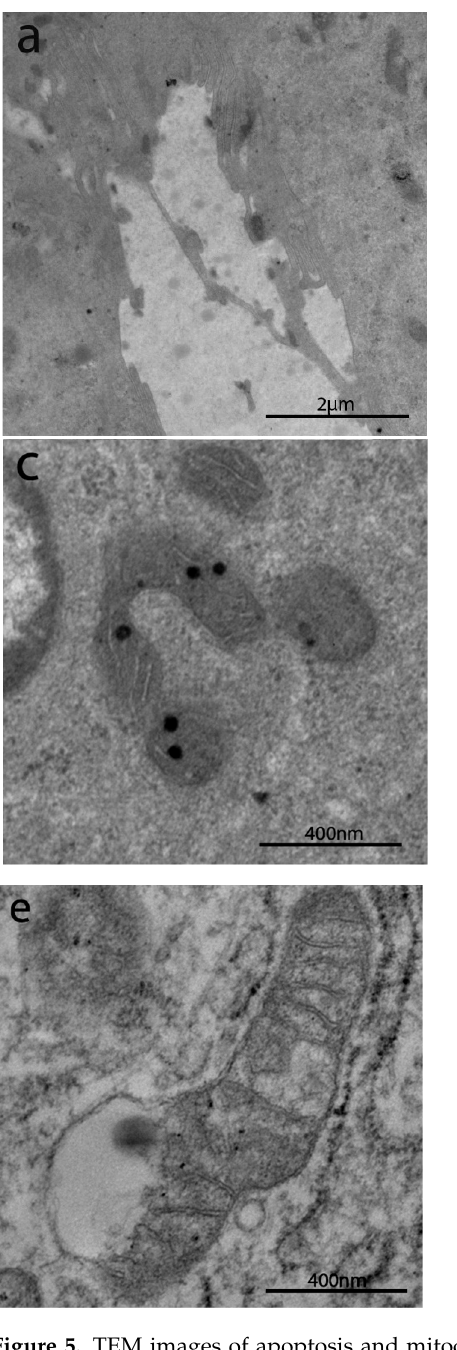
Figure 6. TEM images of chylomicrons, lipid droplets, and mast cells in IBS-like disorders. Chylomicrons in WA ( a ); lipid drops in NCGS and Ni ACM ( b ), mast cells in uCD, WA ( c ), and Ni ACM ( d ). 4. Discussion IBS is a very common disorder that can affect more than 10% of the general population [30]. More recently, researchers have also tried to clarify the nature of IBS-like